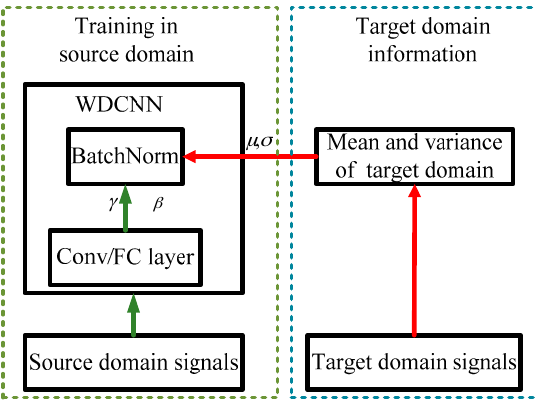
Figure 4 . Domain adaptation framework for WDCNN. Figure 4. Domain adaptation framework for WDCNN. Algorithm 1 AdaBN for